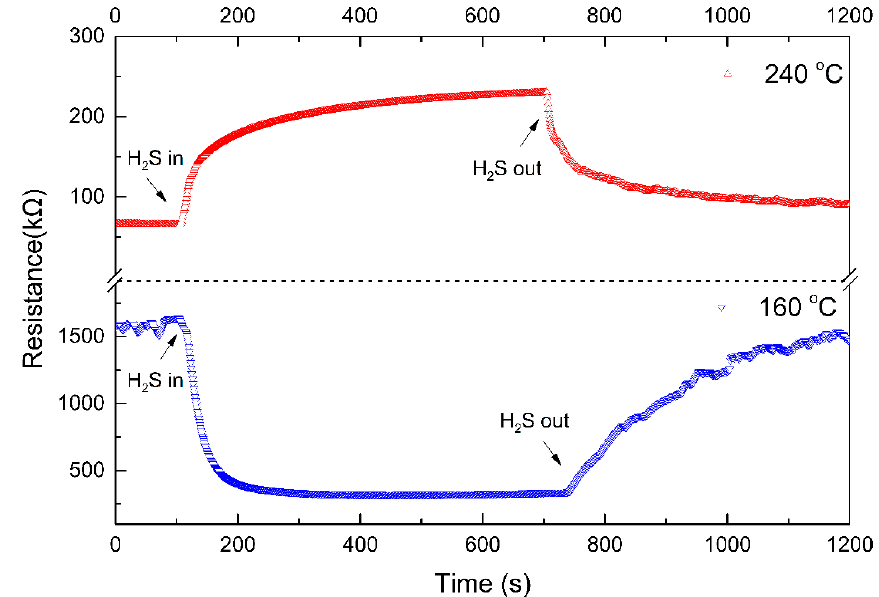
Figure 11. Dynamic response curves of NiO/ZnO-heterostructures-based sensor to 1 ppm H 2 S at 160 °C and 240 °C.